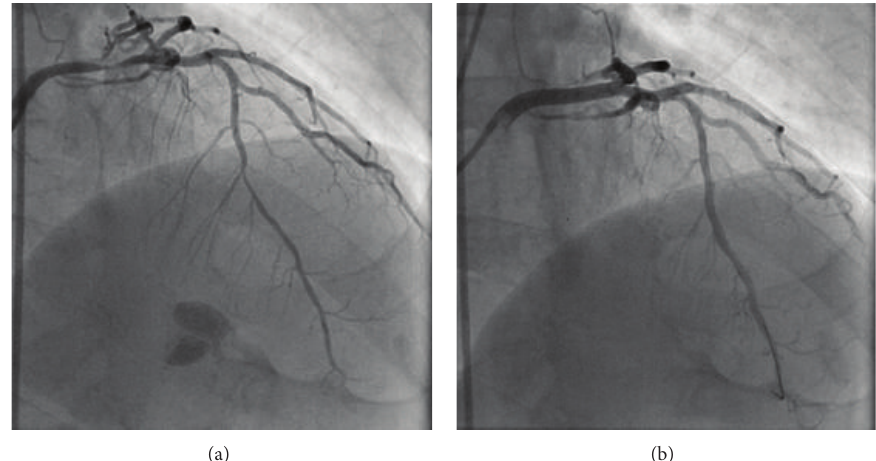
Figure 7: (a) The left graph shows the coronary angiograph before PCI. (b) The right-hand map showed coronary angiograph after